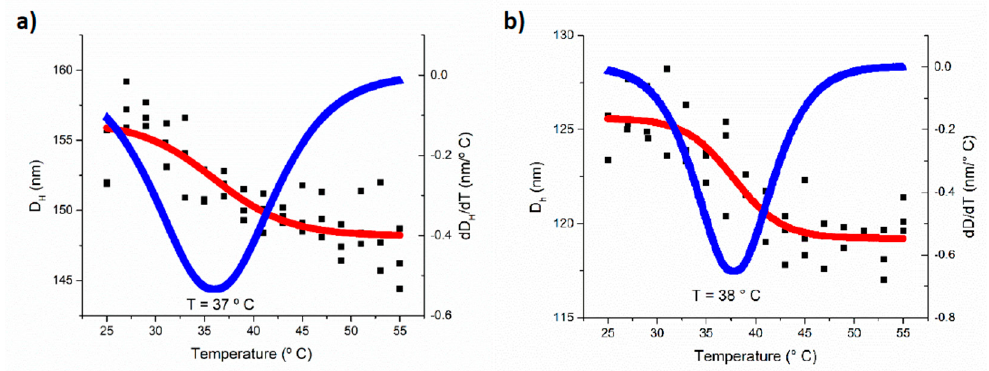
Figure 6. Temperature sensitivity of polymer aggregates at a pH 7.4: ( a ) aggregates formed by P 122 D 54 and ( b ) aggregates formed by P 122 D 87 .